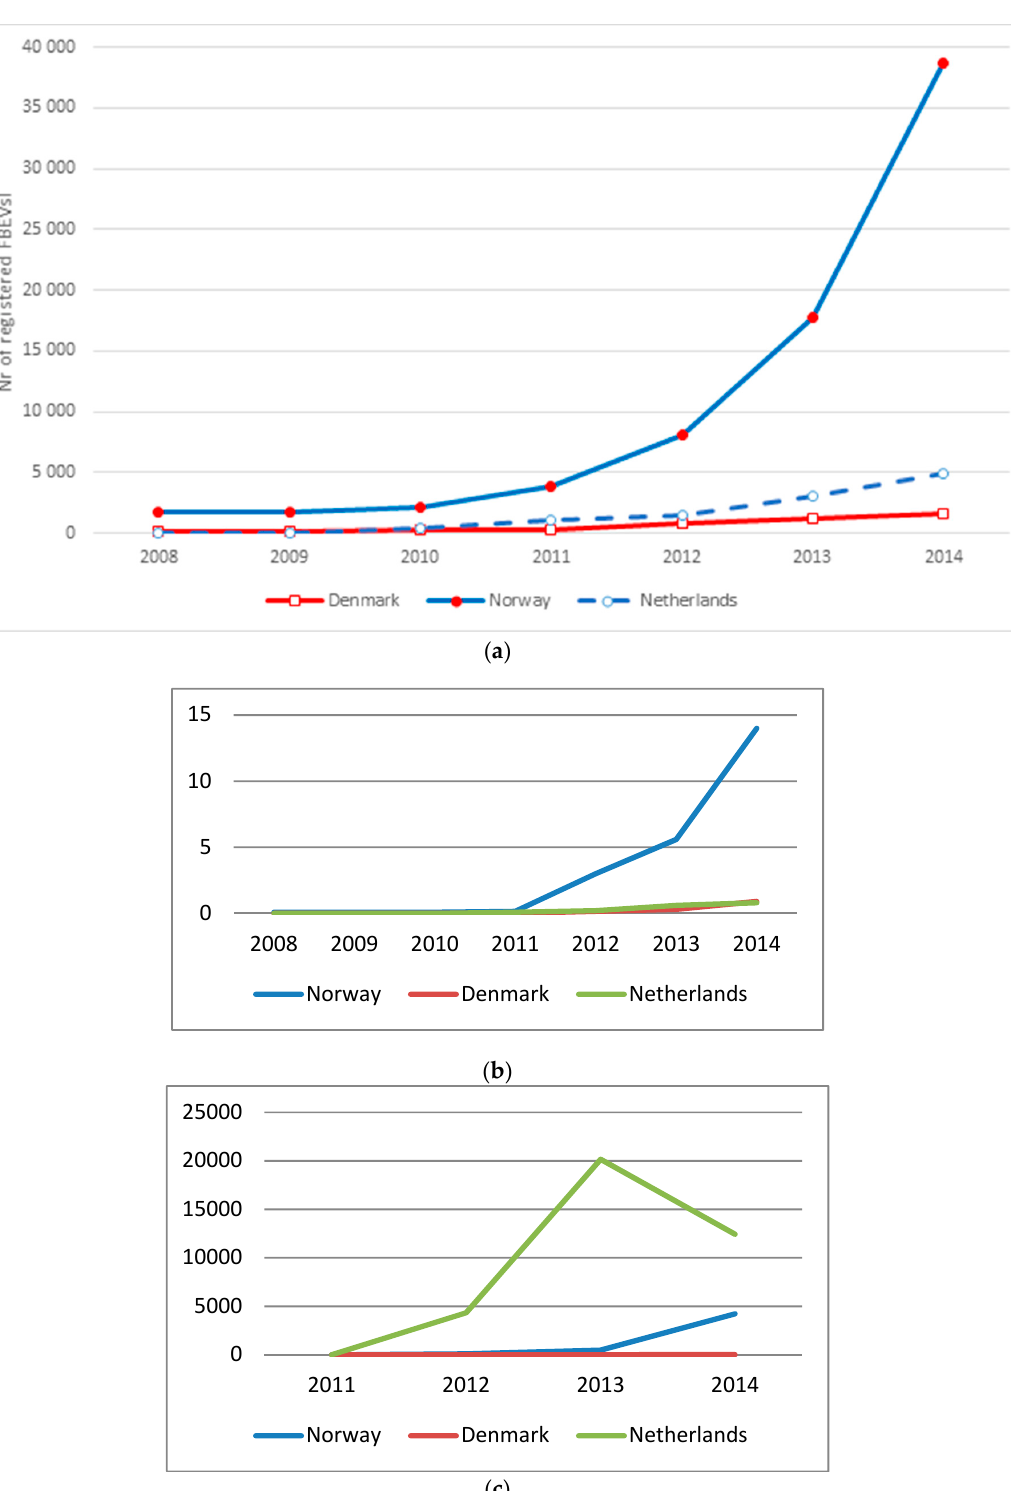
Figure 1. ( a ) Number of newly registered FBEVs in Denmark, Norway and the Netherlands, 2008–2014. Sources: Statistics Denmark, Statistics Norway, RVO. ( b ) FBEV market shares. ( c ) Number of new registered plug-in hybrid electric vehicles (PHEVs).